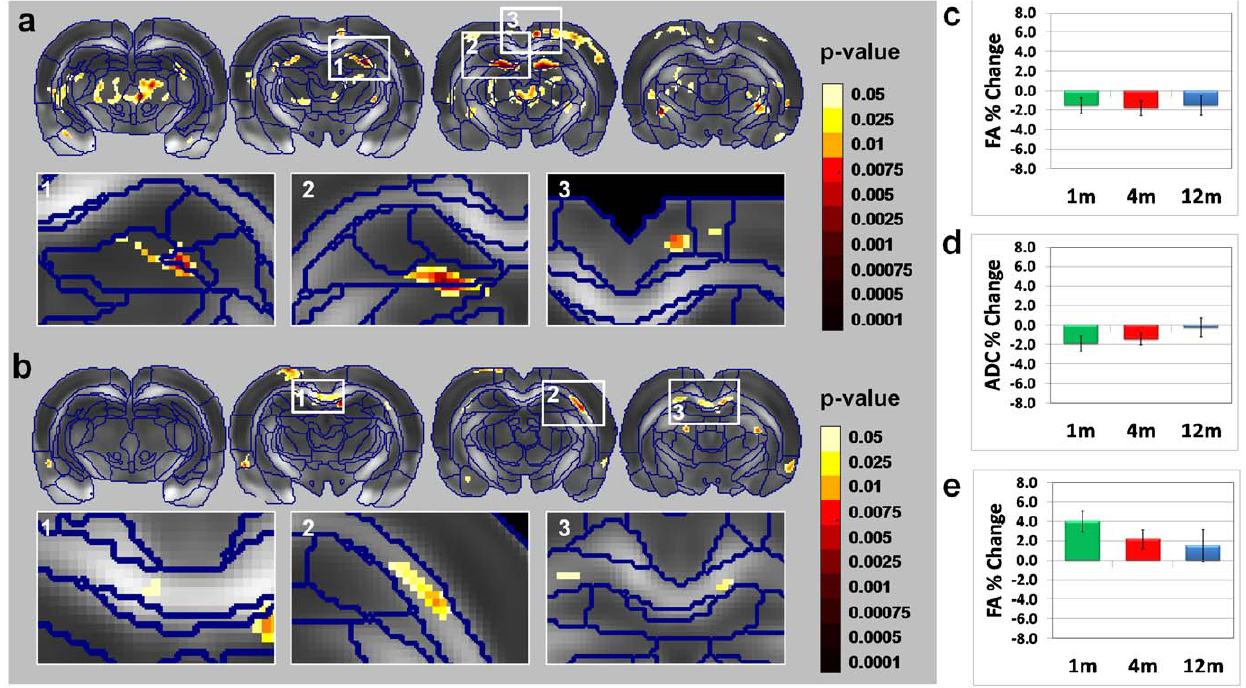
Figure 5. Age dependency of the changes in diffusion tensor imaging induced by spatial learning. ( a ) and ( b ) Statistical parametric maps of the scan time main effect over the three group L subgroups (rats that underwent the water maze task at the age of 1, 4, or 12 months) for ADC and FA, respectively. Voxels that exceed a statistical threshold of P , 0.05 (non-corrected) are colored according to the threshold they exceeded (see color scale), while those that did not exceed the threshold are not colored. We report only on regional clusters that exceeded a statistical threshold of P , 0.05 corrected for multiple comparisons (using the FDR method); these regions are shown in the insets. The regional pattern of the main effect (in both the ADC and the FA maps) includes the dentate gyrus (DG) and cingulate cortex as well as the corpus callosum. Post-hoc analysis of the main effects revealed that in some regions the magnitude of DTI changes between the two scans was similar across ages. Examples are reduction in ADC in the in the DG ( c ). Other regions show an age-dependent relationship in which effects were more pronounced in younger than in older mice. This was observed in the CG ( d ) and the corpus callosum ( e ).